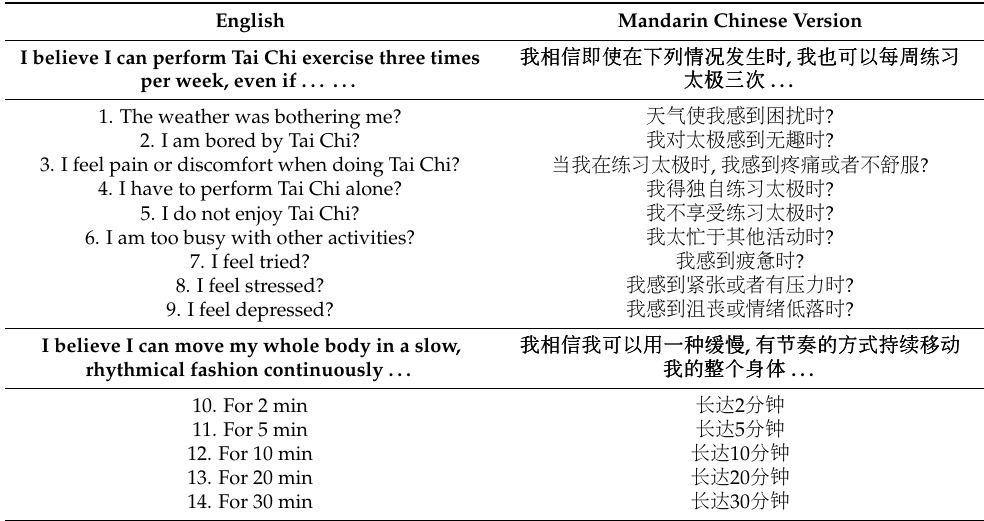
Table 1. Items of TCSE scale (original English version and Mandarin Chinese version). English Mandarin Chinese Version